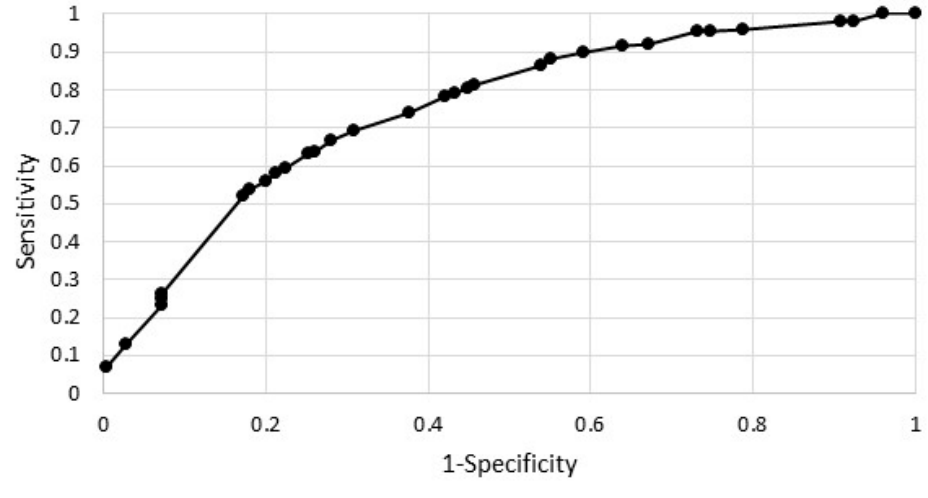
Figure 1. ROC curve.